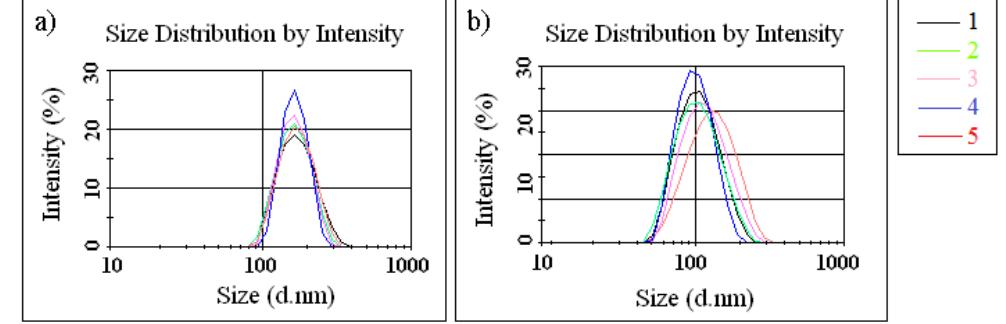
Figure 1. The average particle size of pristine silica nanoparticles (SiO 2 NPs) and functional SiO 2 NPs dispersed in: ( a ) ethanol and ( b ) methylene chloride.